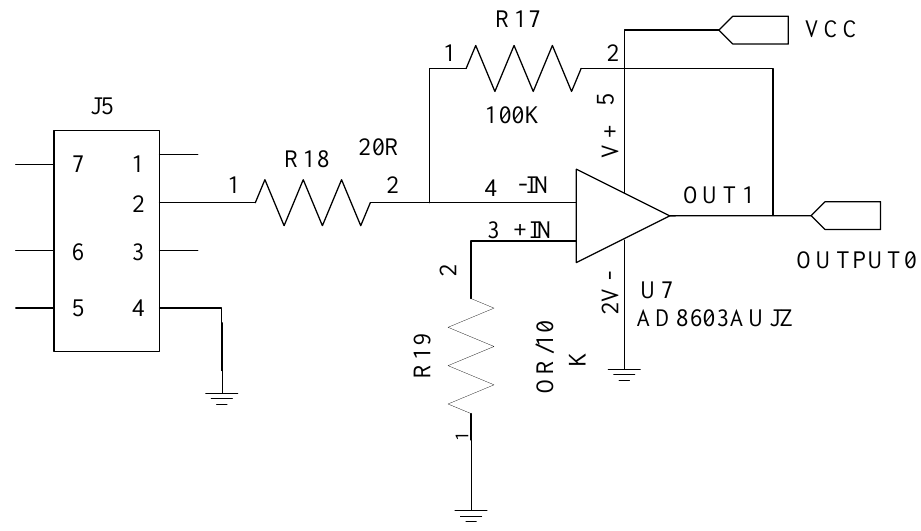
Figure 2. Schematic of the connecting circuit for the wireless corrosion